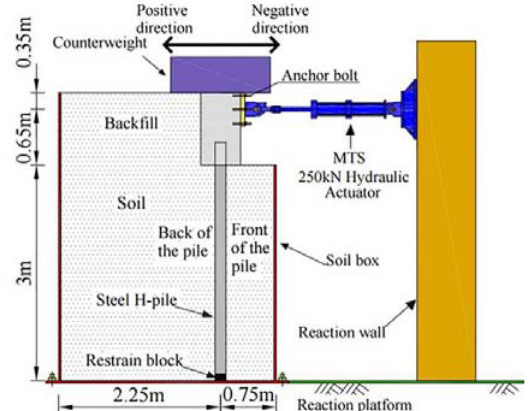
Figure 7. Loading arrangement.